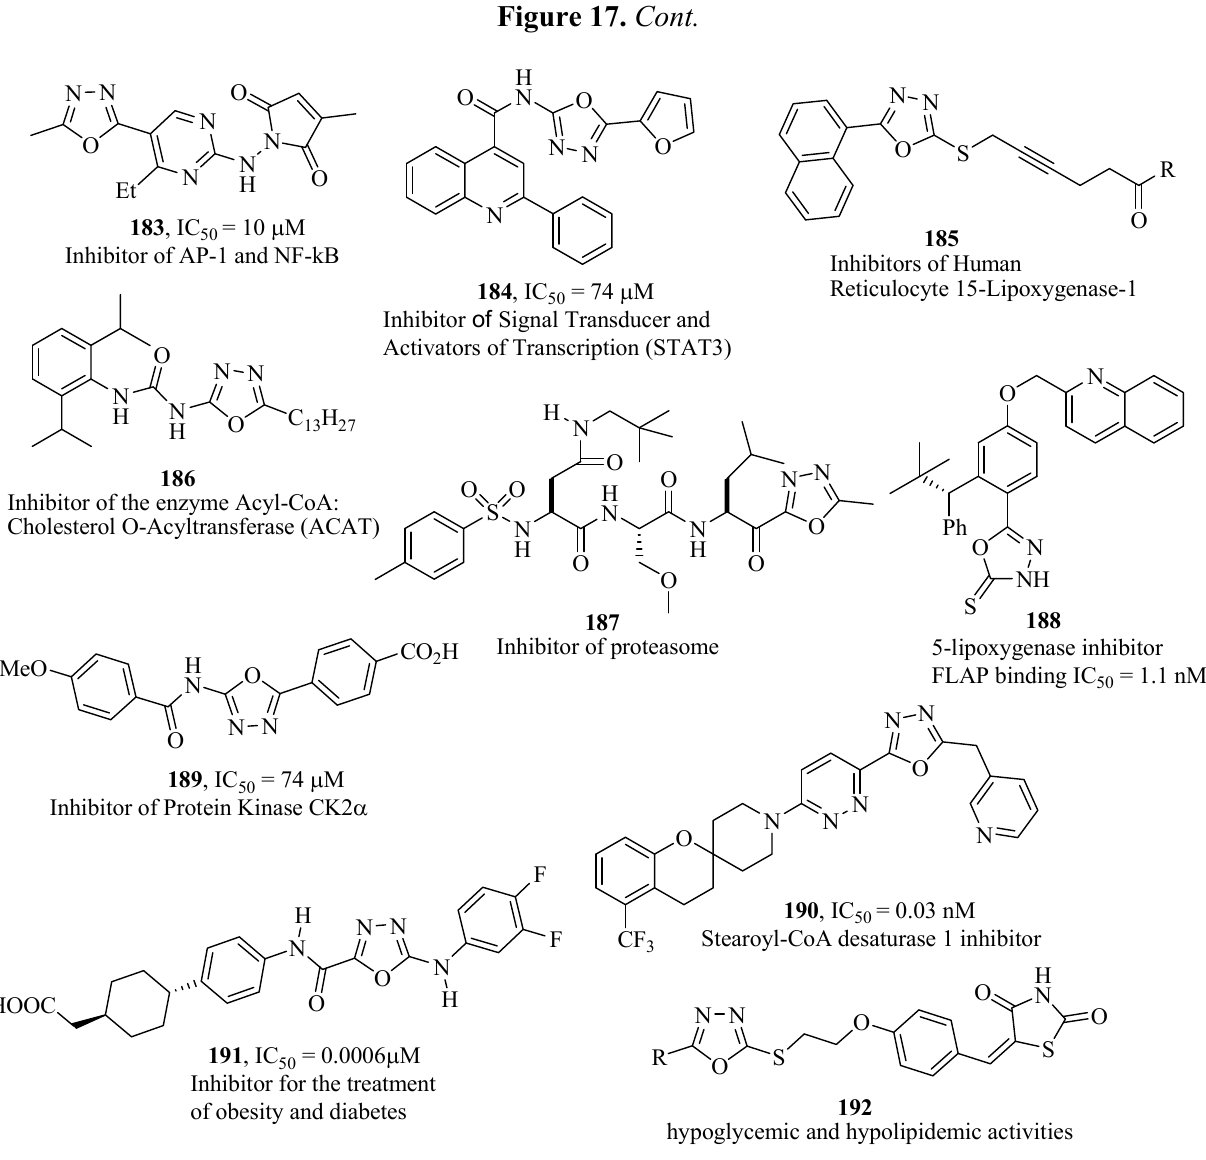
Figure 18. Other biological and pharmacological activities of 1,3,4-oxadiazoles